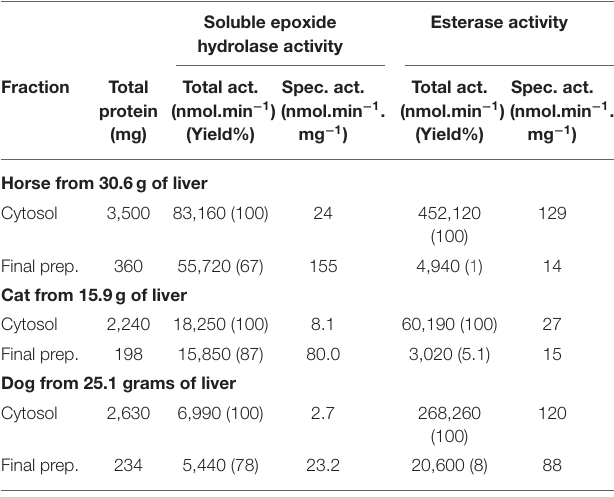
TABLE 2 | Screening assay performances. Assay Horse sEH